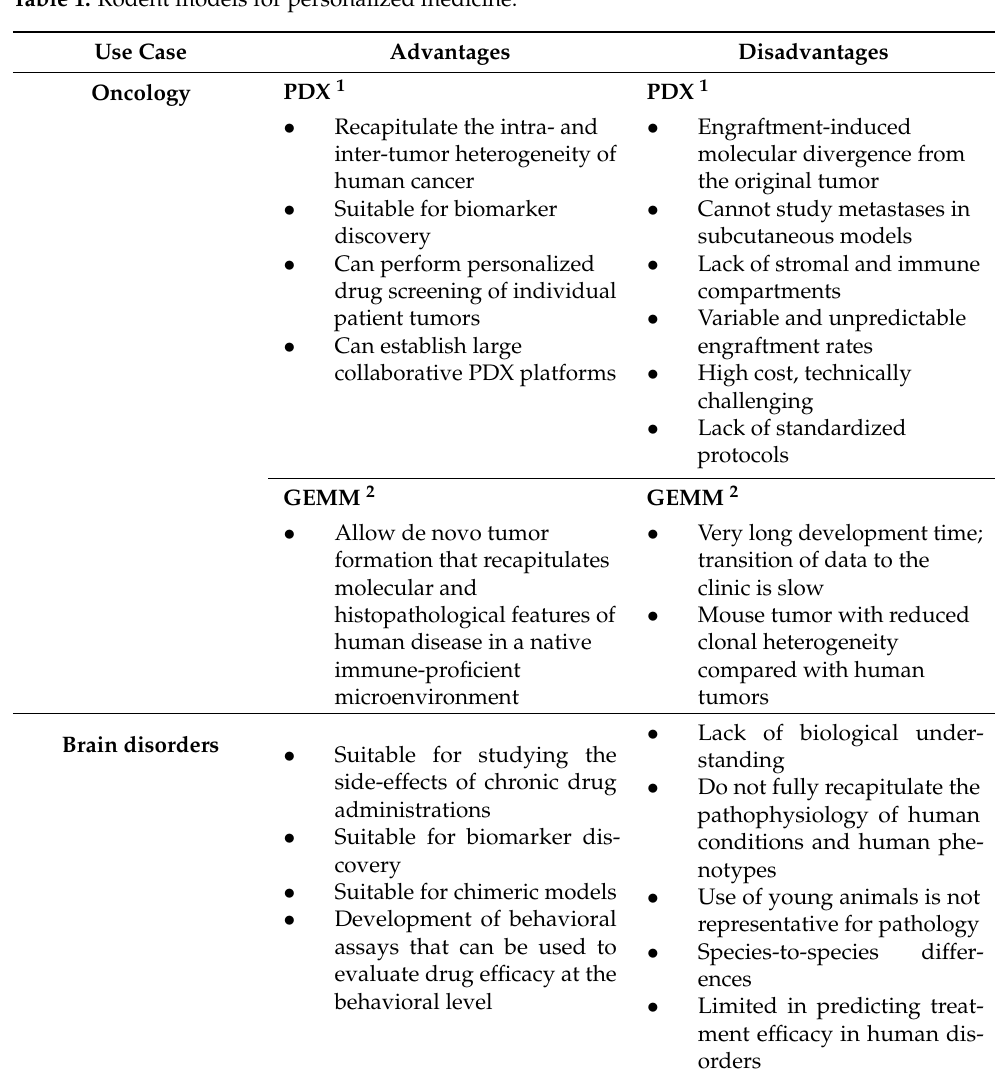
Table 1. Rodent models for personalized